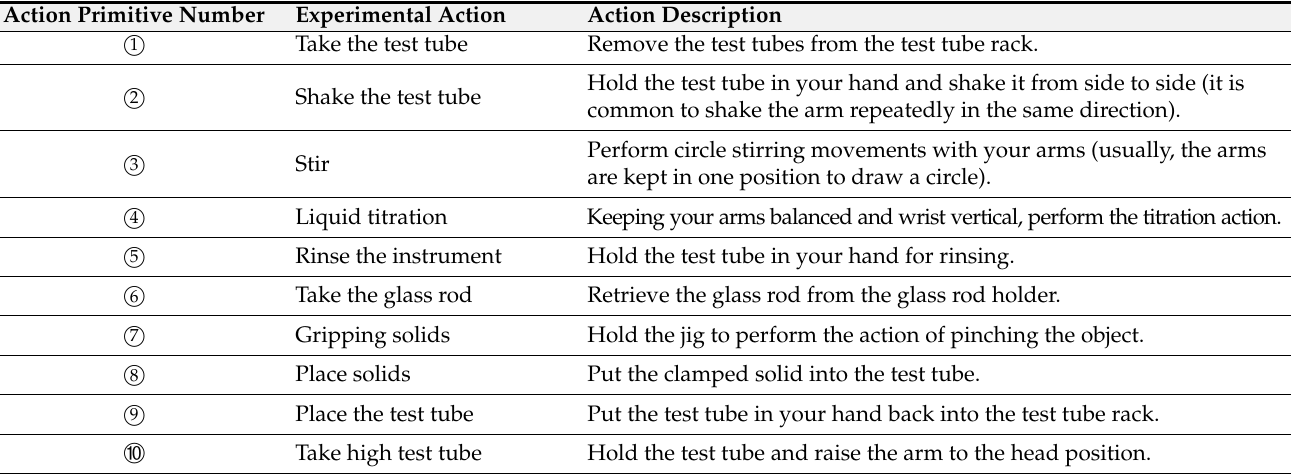
Table 4. Action primitives.